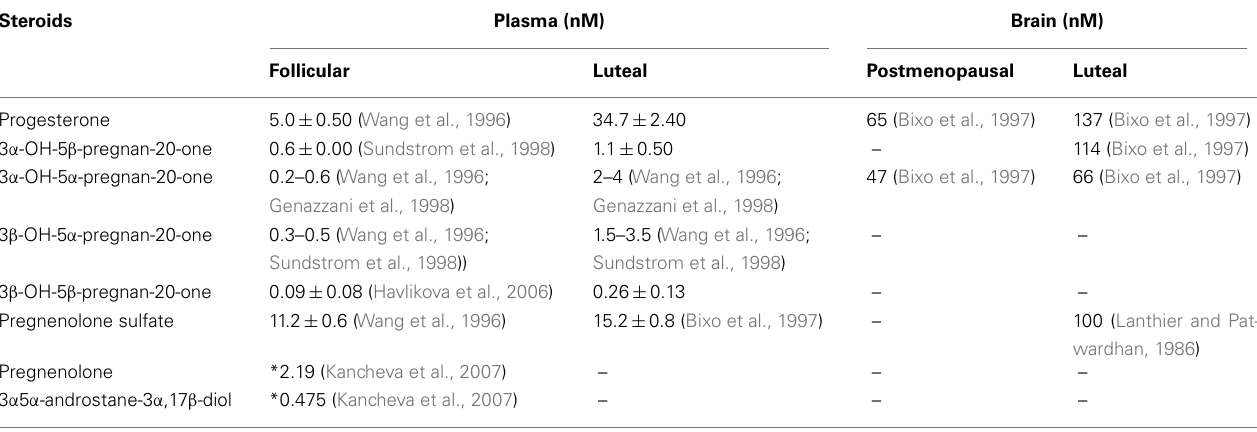
Table 1 | Neurosteroid concentrations in human plasma and brain (mean ± SEM).